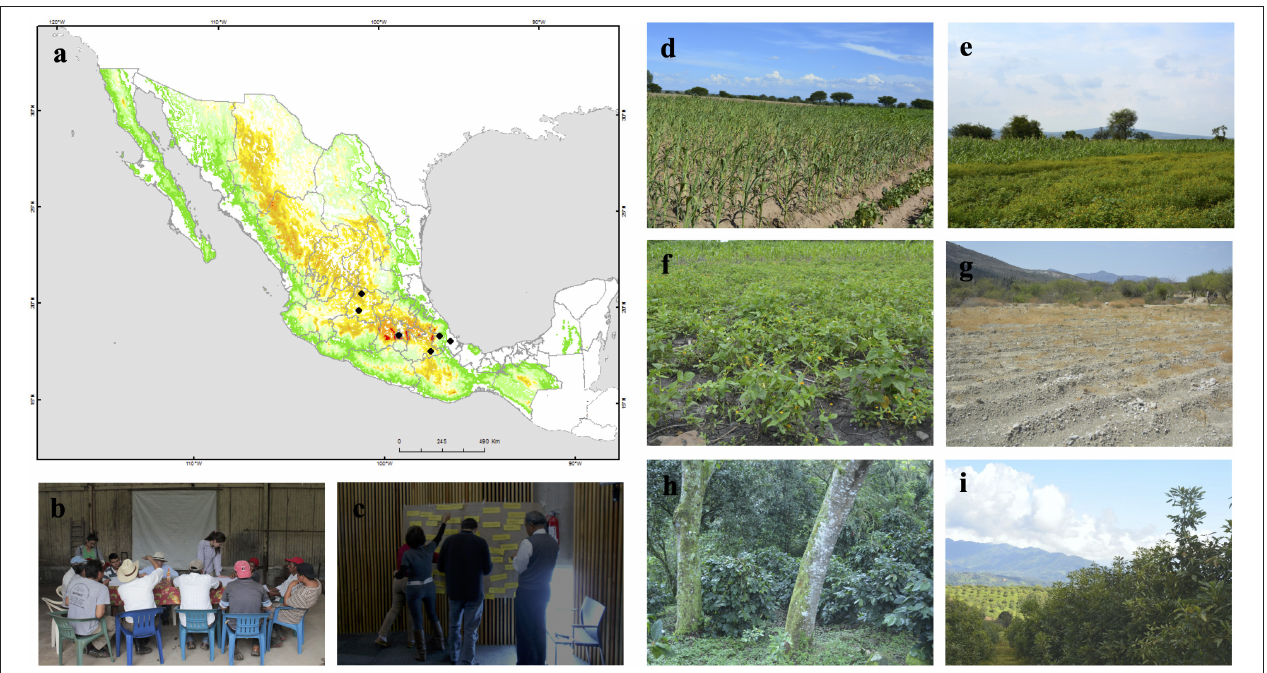
FIGURE 1 | (a) Localities of interest in the states of Guanajuato, Puebla, Veracruz and Mexico City [altitude map by Comisión Nacional para el Conocimiento y Uso de la Biodiversidad (1998) ]. Focus groups with coffee producers (two co-authors provided consent to be identifiable in the image) (b) and officials of the federal government (c) . Sites where maize and beans are cultivated (d–g) and sites where coffee and avocado are produced (h,i)